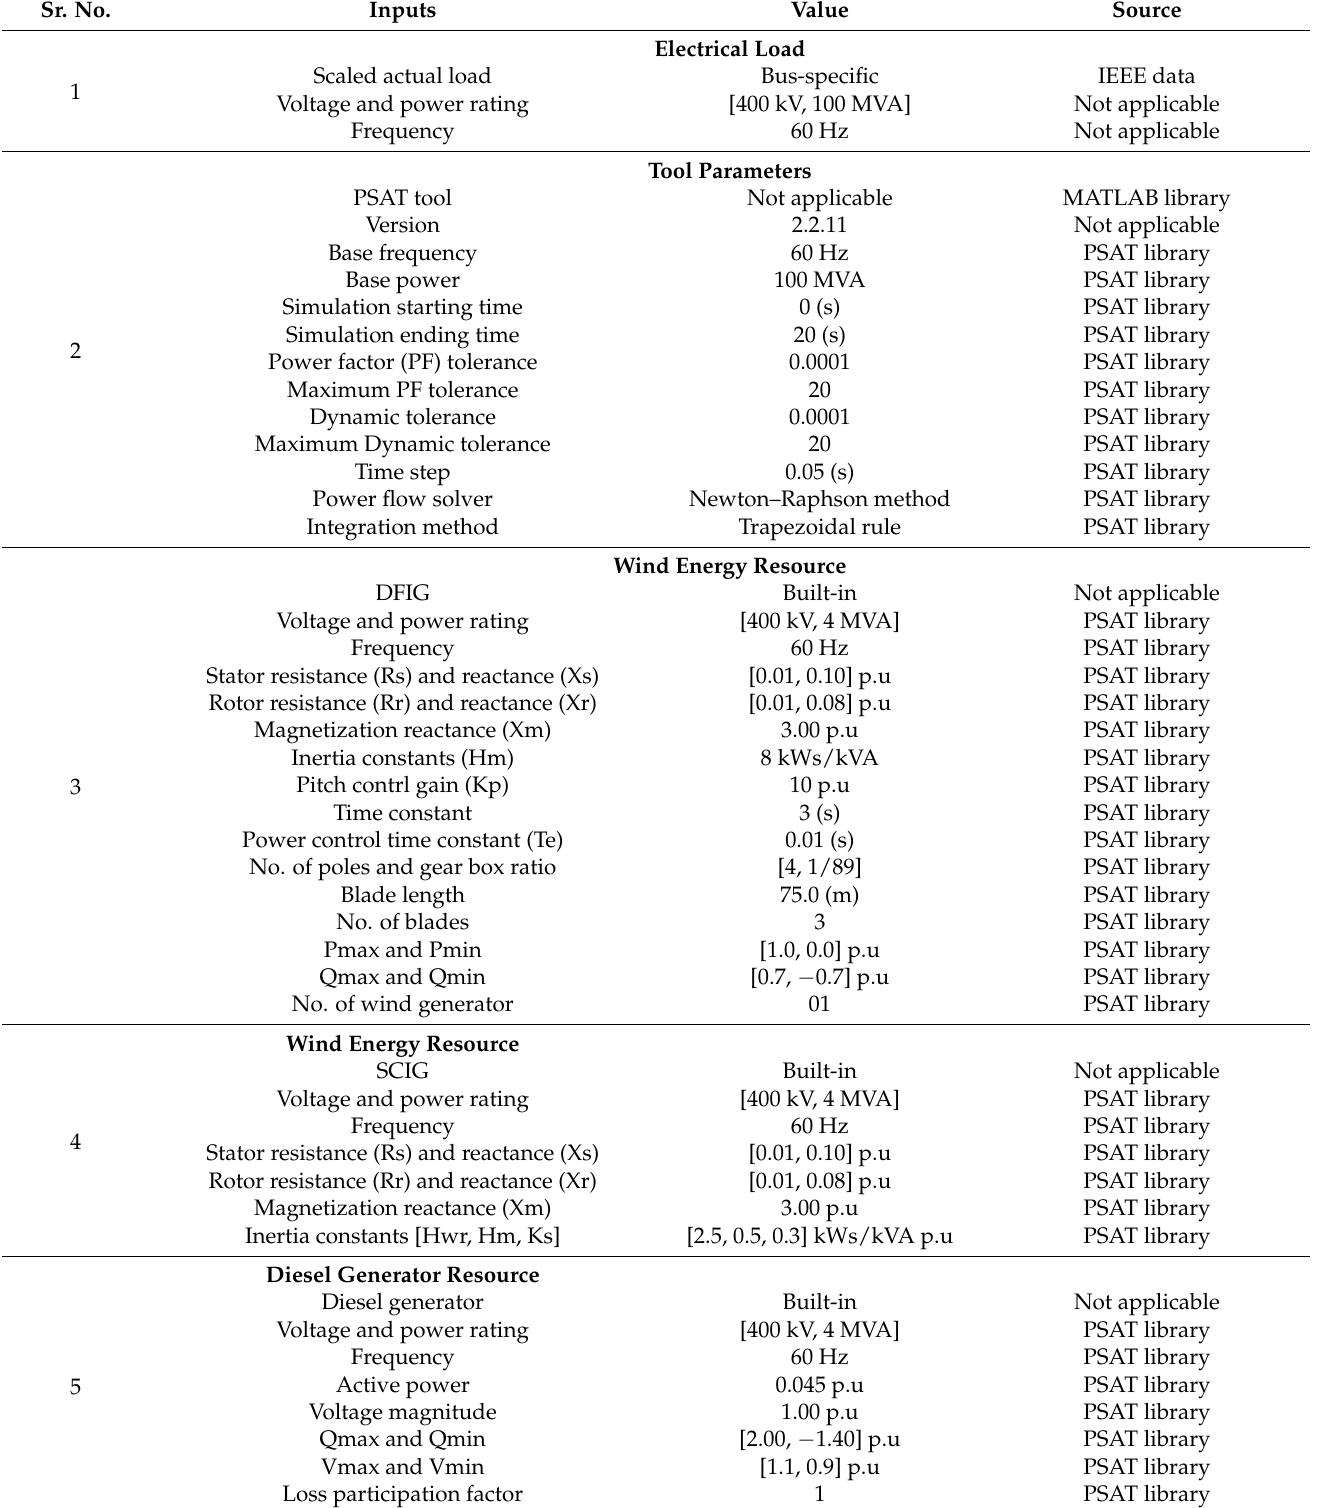
Table A1. Dataset, inputs, assumptions and other major parameters used in this study. Sr.